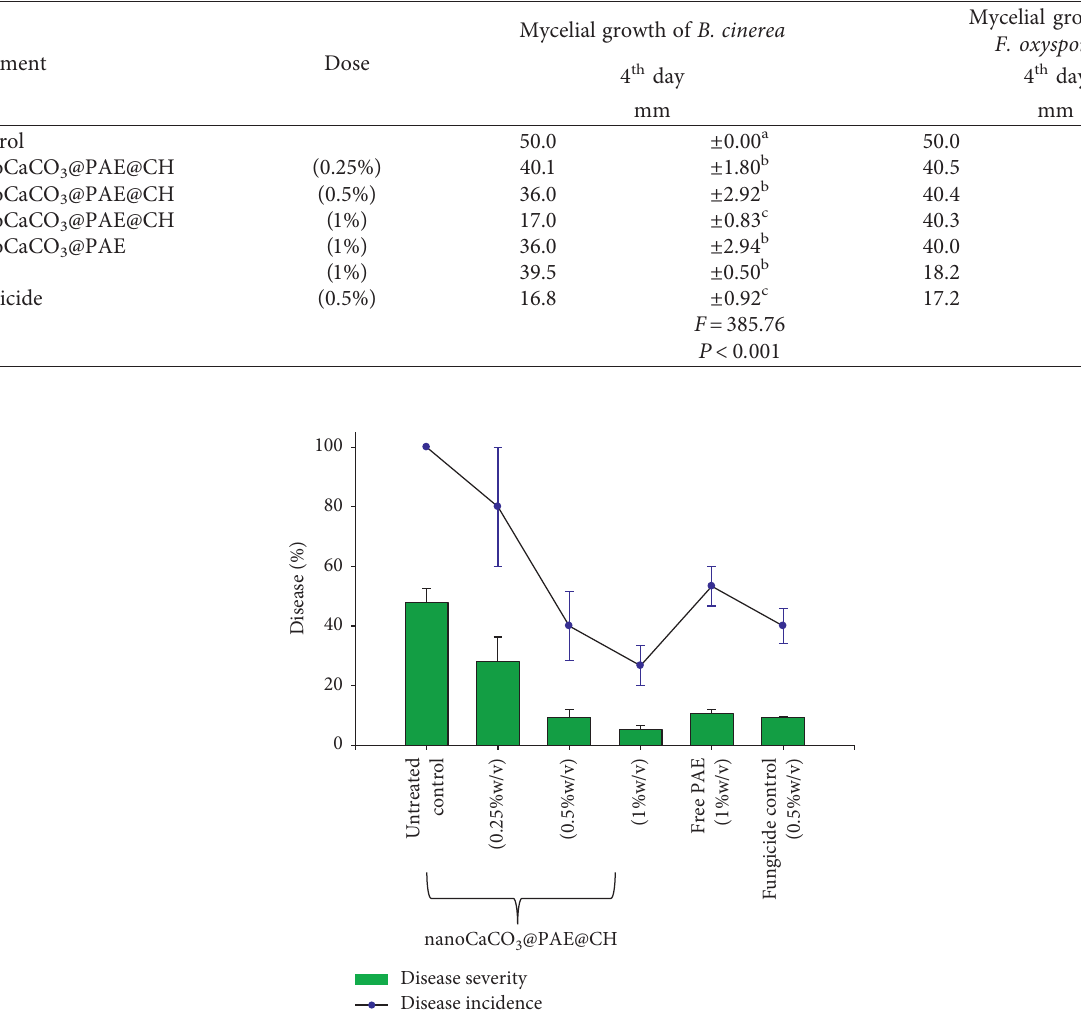
Figure 7: Increasing doses of nanoCaCO 3 @PAE@CH on disease incidence (DI) and disease severity (DS) of gray mould ( Botrytis cinerea ) on